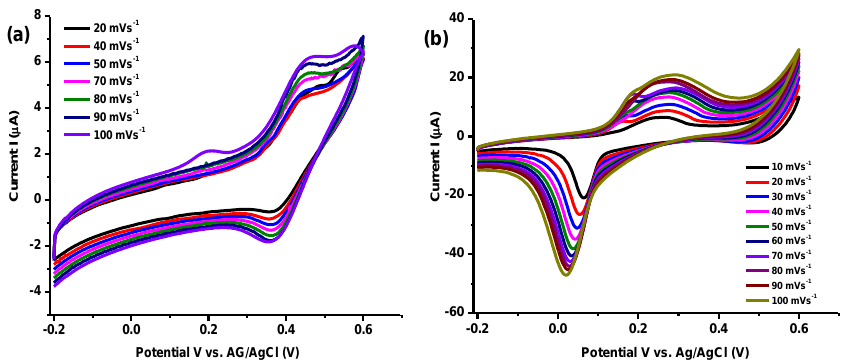
Figure 9. Voltametric profiles using Ti 3 C 2 T x /Ag 2 CrO 4 electrode ( a ) in 1 M KOH ( b ) 0.1 M H 2 SO 4. Table 4. Comparison of the specific capacitance with earlier MXene based nanocomposite elec- trodes.